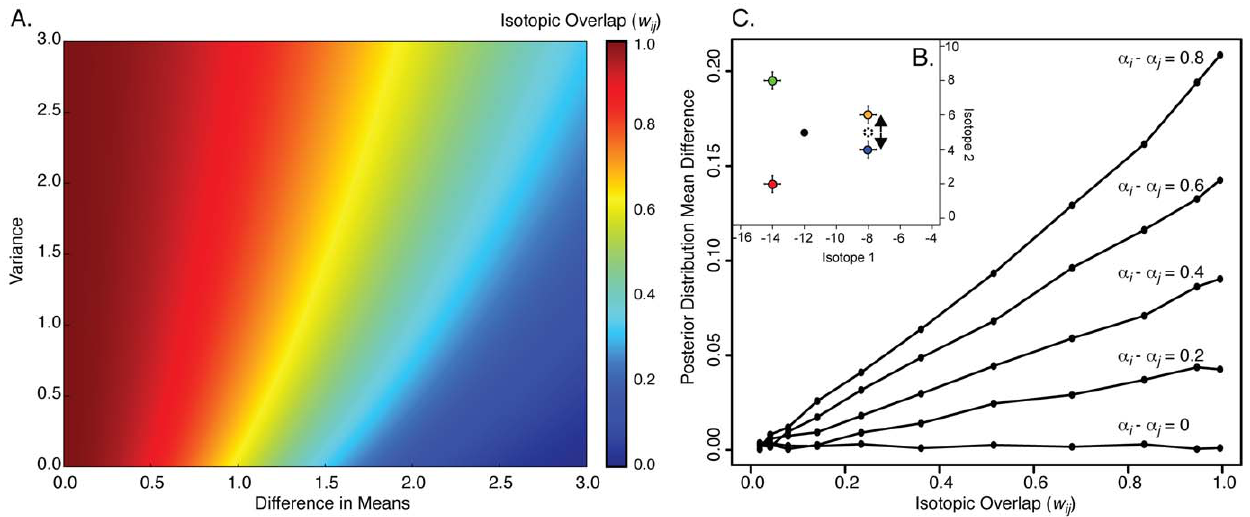
Figure 2. Sensitivity analysis of the weighting procedure as a function of isotopic similarity and the difference in proportional availability of isotopically similar prey. A ) Sensitivity analysis of Pianka’s measure of density overlap ( w ij ) across differences in mean values and variance of two bivariate normal isotopic distributions. When variance is small, w ij decreases sigmoidally as the difference in means increases. Larger variance predictably tends to linearize the relationship. B ) The mixing space of our hypothetical scenario permits manipulation of isotopic overlap between two prey (blue and orange; the consumer is black) without altering mixing model estimates of summed proportional contribution to diet of the two prey (cf. Fig. S3). C ) An analysis of the effect of model parameters (density overlap, w ij , and availability differences, a i 2 a j ) on the final weighted and renormalized posterior distributions, measured by the difference of final distribution means for blue and orange in the hypothetical isotopic dataset (Fig. 1). The model is assessed across all possible values of w ij (0:1), and across five prey availability scenarios. There is a strong linear effect of isotopic overlap on the difference in means of the weighted posterior probability distributions. The slope of this relationship is determined by availability differences.